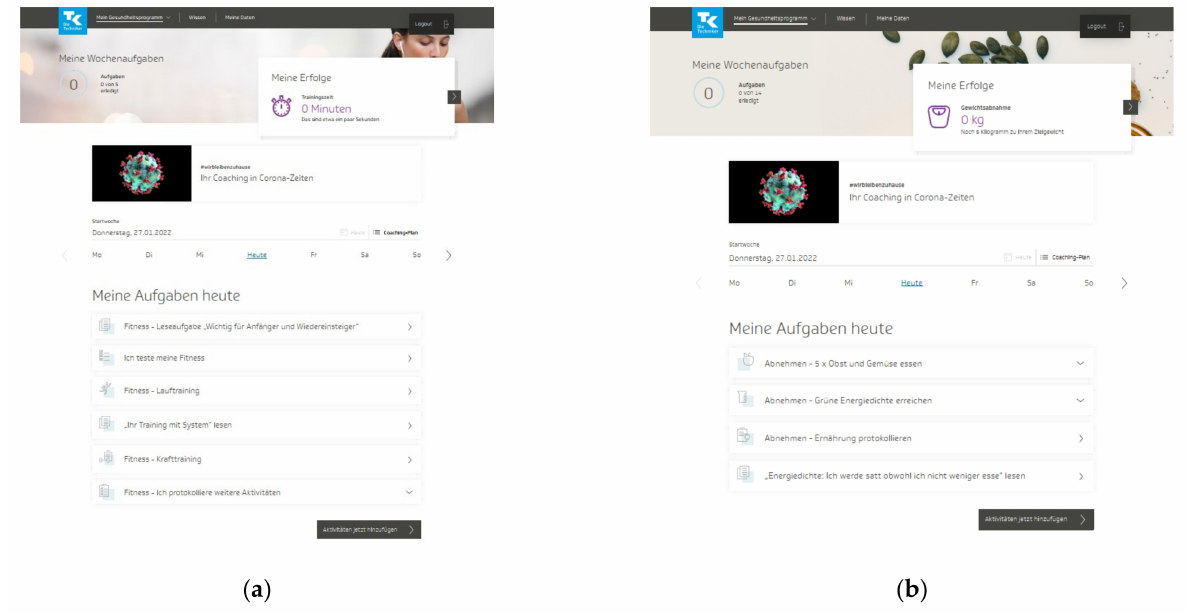
Figure 1. Dashboard of the “TK-HealthCoach” (TK-HC): ( a ) “TK-FitnessCoaching” (TK-FC); ( b ) “TK-WeightLossCoaching” (TK-WC). Source: Project’s landing page (https://gesundheitsprogramm. tk.de/de/studien/gesundheitsziele (accessed on 21 October